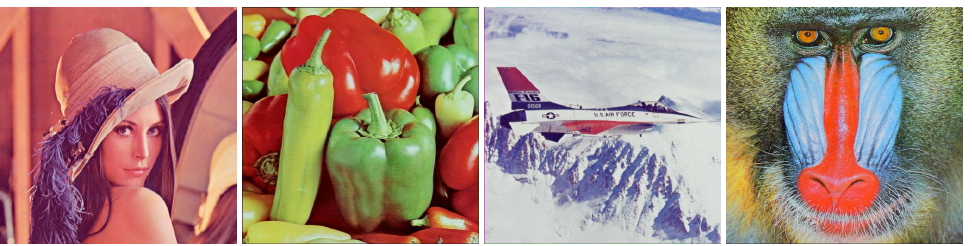
Figure 3. Selected benchmark color images. Table 1. Comparison of MSE values between SOM, GCMA, PSO-CIQ, and